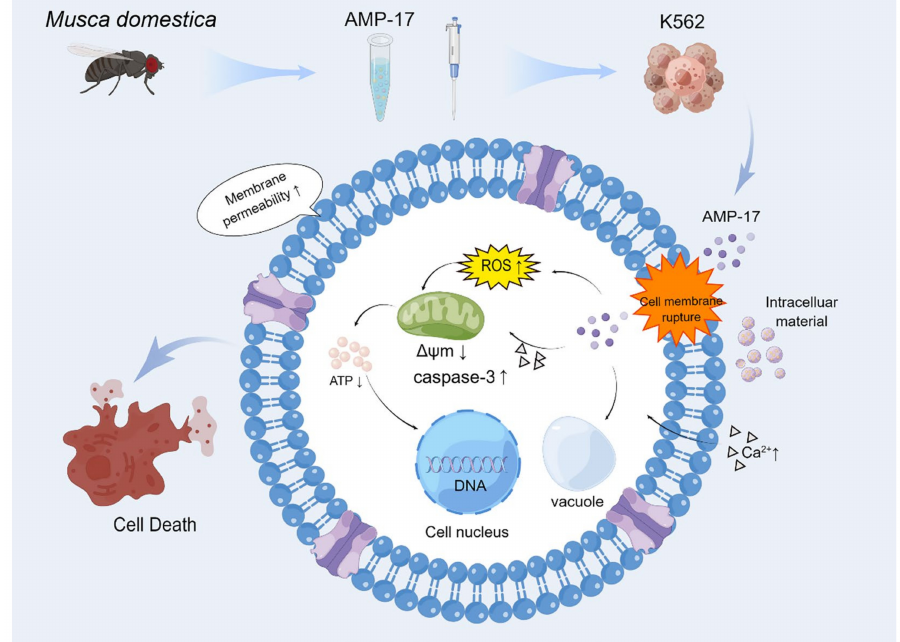
Figure 7. Schematic diagram of the proposed mechanism of AMP-17 against K562 cells. AMP-17 disrupts K562 cell membrane integrity and increases membrane permeability, allowing the peptide to enter the intracellular. Subsequently, this peptide stimulation resulted in accumulation of ROS and increased inward flow of Ca 2+ , which further caused depolarization of mitochondrial membrane potential and impaired ATP synthesis. Therefore, AMP-17 may induce apoptosis in leukemia K562 cells through disrupting mitochondria and activating Caspase-3 activity. By Figdraw (www.figdraw. com, accessed on 11 May